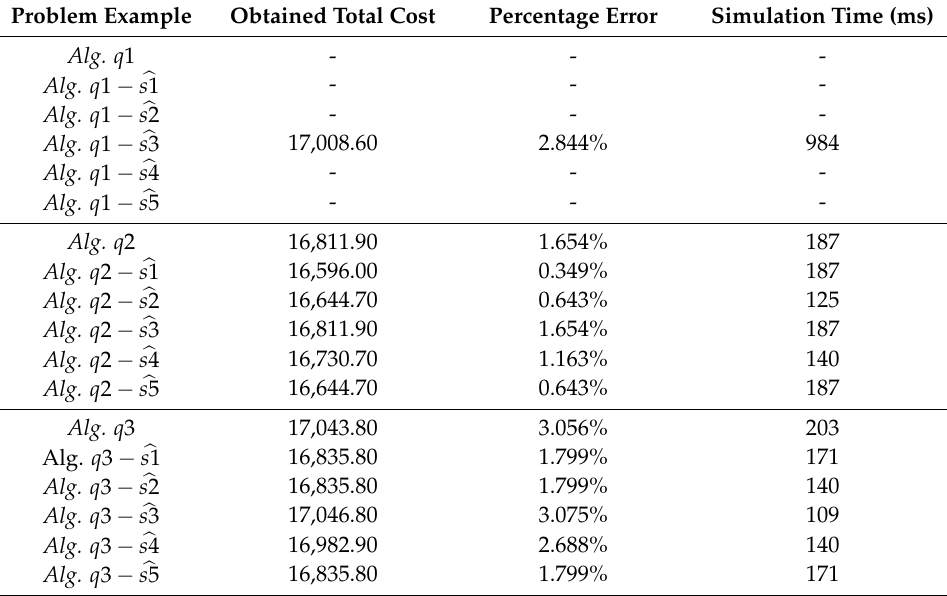
Table 5. Obtained results for regular network GR-1b (Suboptimal cost 16,538.30).